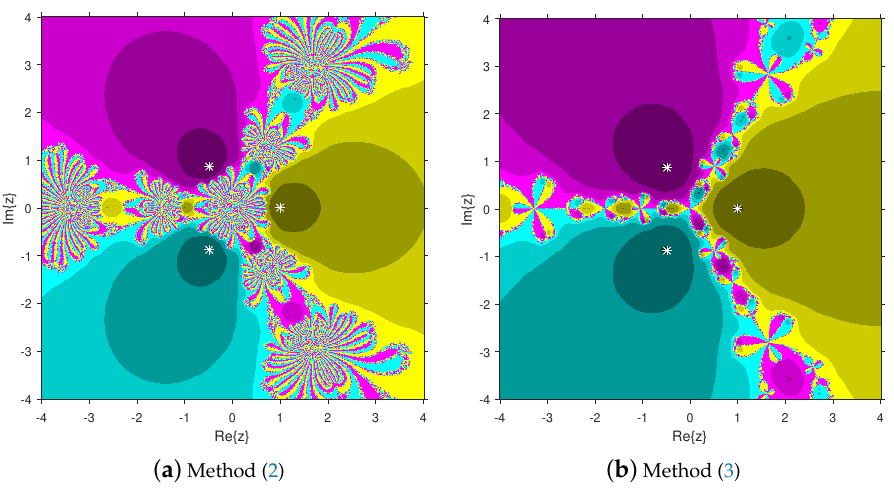
Figure 2. Comparison of attraction basins associated with third-degree polynomial O 2 ( z ) = z 3 − 1.